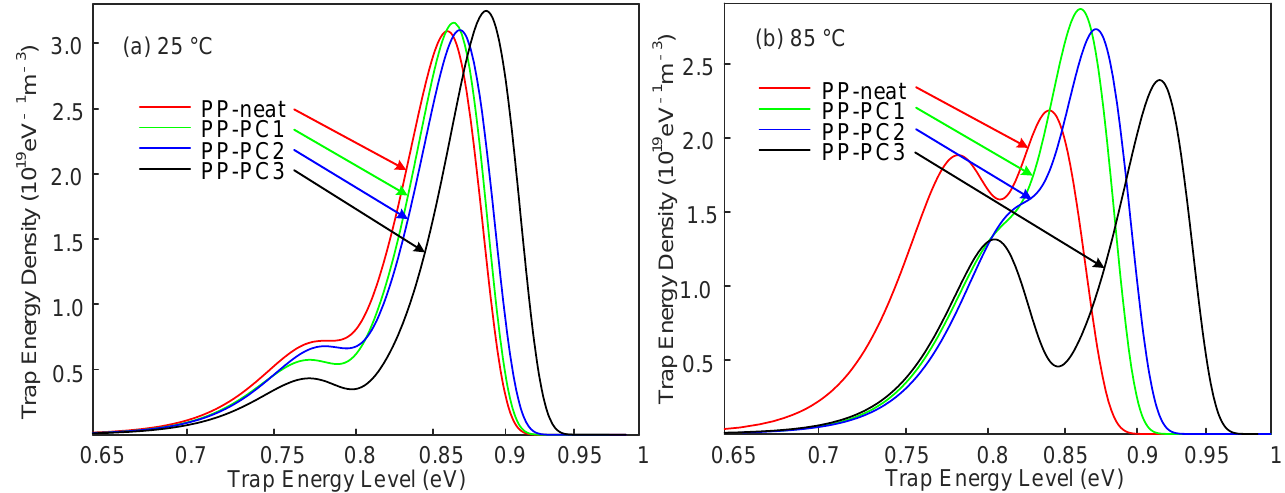
◦ C. Figure 6. Trap level distribution of samples at ( a ) 25 and ( b )85 °C. Figure 6. Trap level distribution of samples at ( a ) 25 and ( b ) 85 The carrier mobility at different temperatures was obtained by the method of SPD [24], as shown in Figure 7. It can be obtained that the temperature greatly affects the carrier mobility, and the carrier mobility increases at high temperatures. More energy can be obtained by charge carriers at higher temperatures, which makes charge carriers detrap much easier. The increased detrapping probability leads to increased transport of the charge carrier from one trap to another trap, which increases the carrier mobility. Since there is a positive correlation between conductivity and carrier mobility, the trend of carrier mobility with temperature explains the rise of conductivity with temperature, as shown in Figure 3.